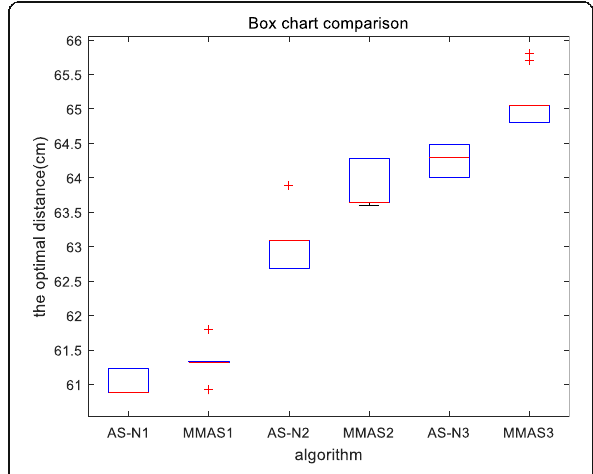
Fig. 9 Complex environment 2 box chart comparison